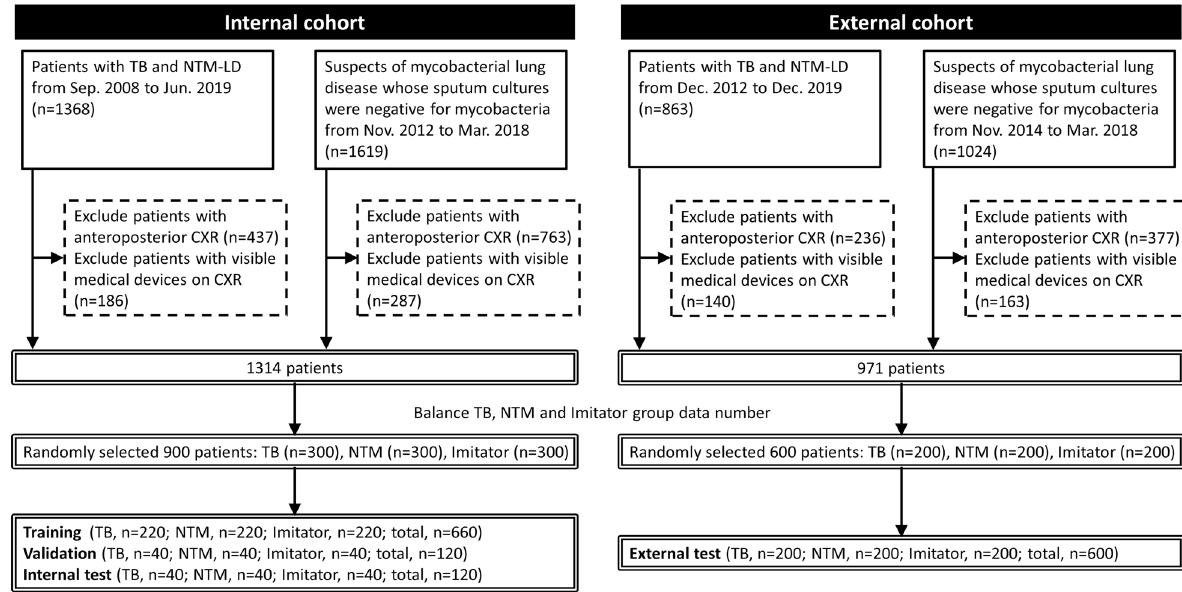
Fig. 1 Flowchart of dataset establishment from patients with presumptive mycobacterial lung diseases is presented. In brief, a total of 2987 and 1887 patients with tuberculosis (TB), non‑tuberculous mycobacteria lung disease (NTM‑LD) or suspicious of mycobacterial lung disease whose sputum cultures were negative for mycobacteria (Imitator) were identified in the internal and external cohort, respectively. After excluding patients with anteroposterior chest X‑ray (CXR) or with visible medical devices on CXR, 1314 and 971 patients were enrolled in the internal and external cohort. Then, we randomly and equally collected 300 patients for each TB/NTM‑LD/Imitator group in the internal cohort, and 200 patients for each TB/NTM‑LD/Imitator group in the external cohort to ensure our model could fairly learn from each diagnosis. Finally, 900 patients in the internal cohort were randomly assigned to one of the three datasets: training, internal validation and internal